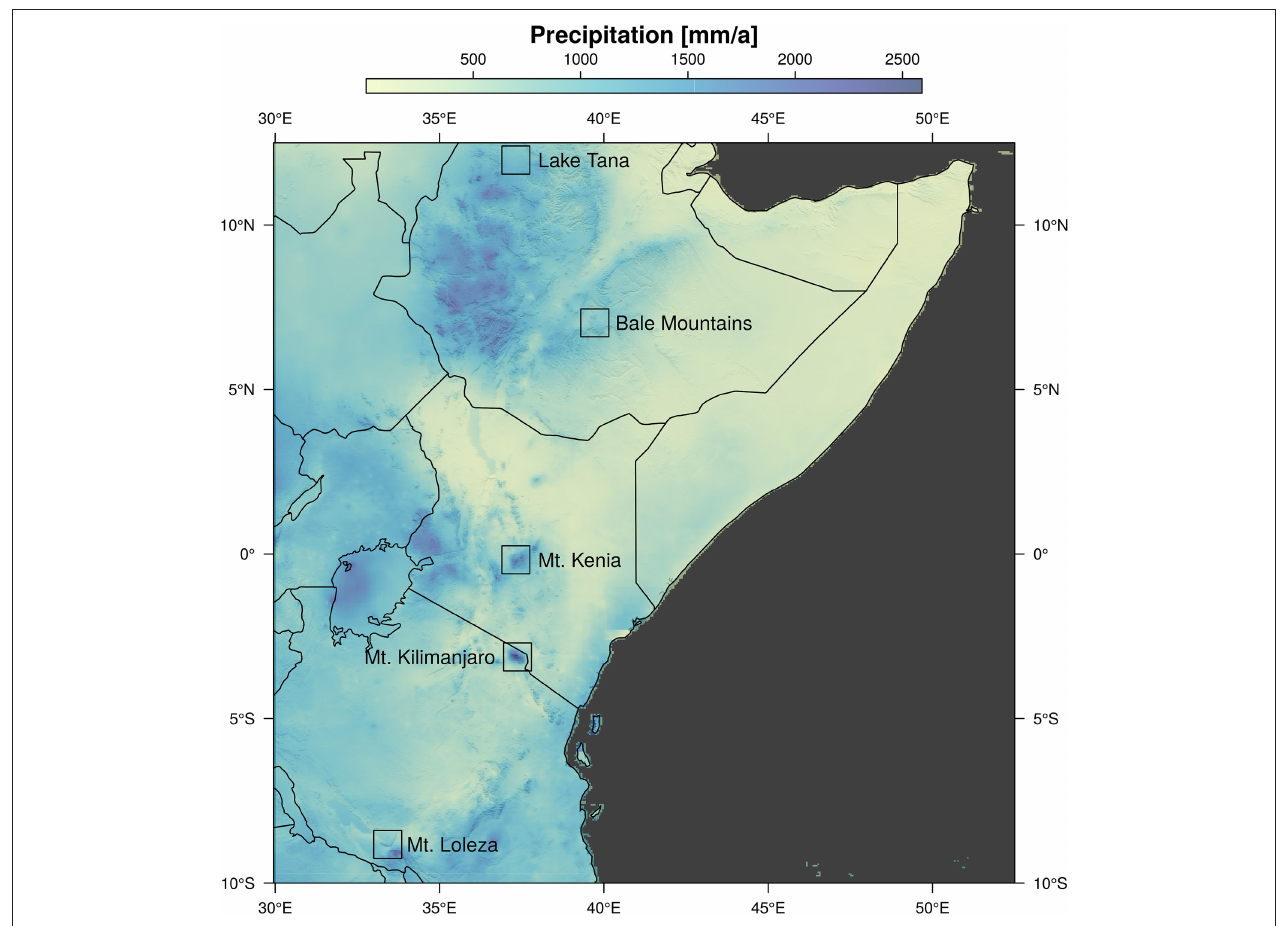
FIGURE 1 | Mean annual precipitation between 1982 and 2010 in the response domains. Black squares show the locations of the small response